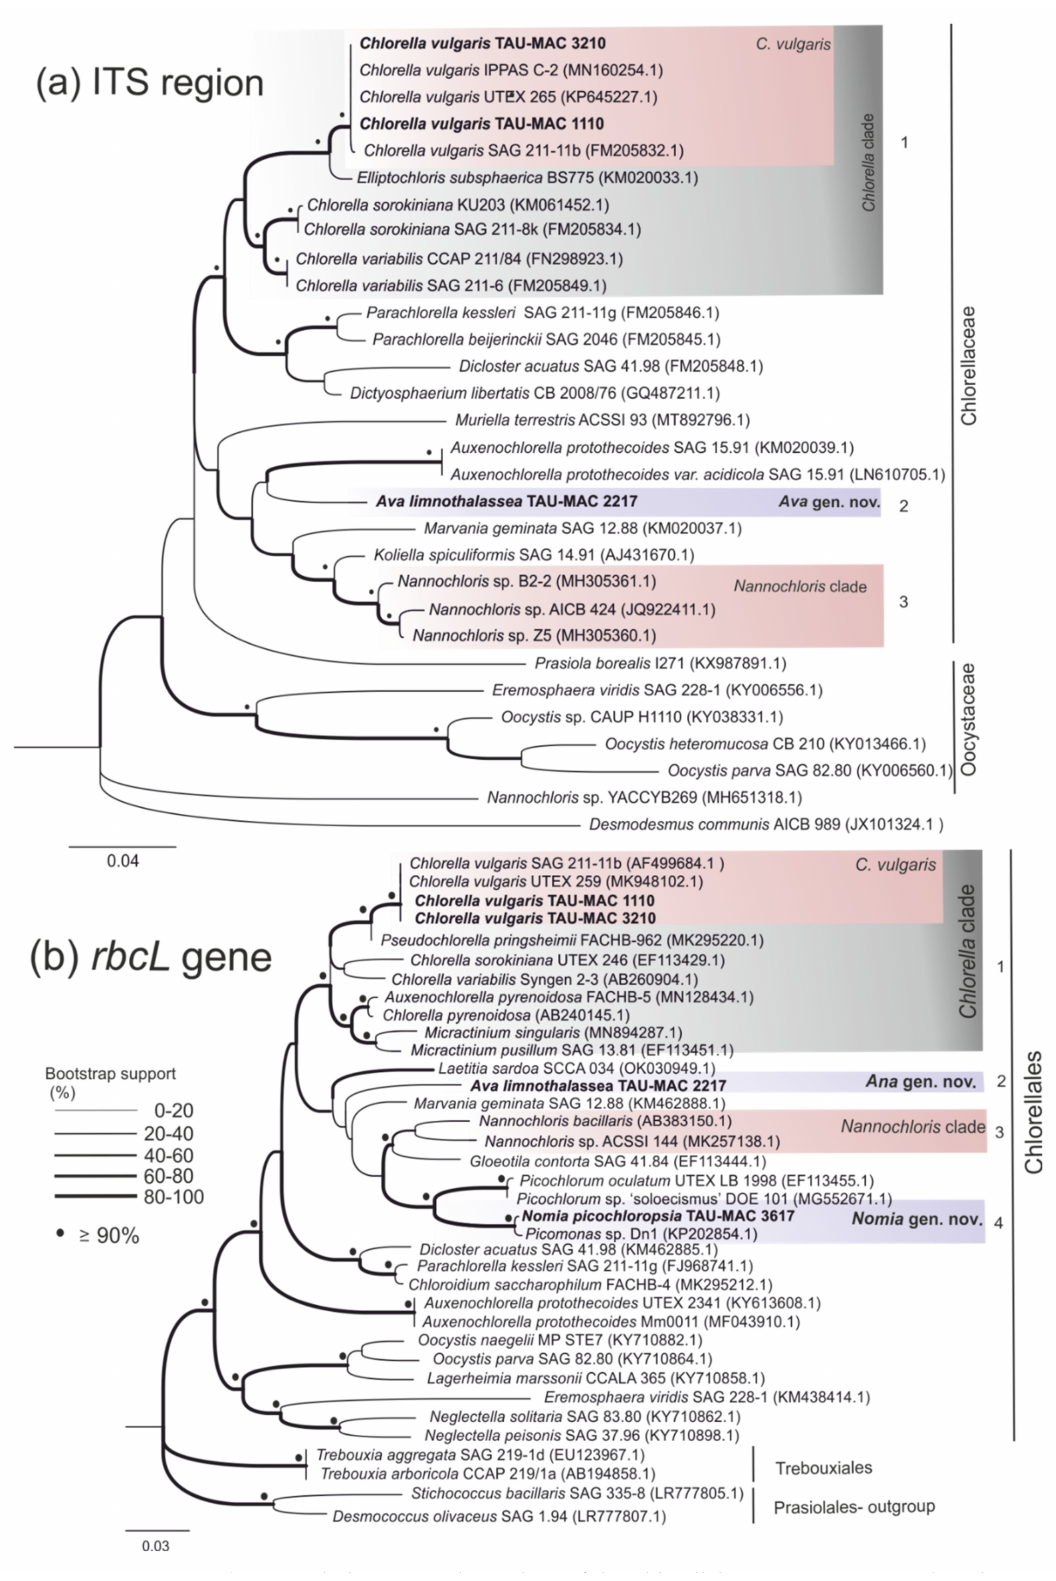
Figure 3. Phylogenetic relationships of the Chlorellales TAU-MAC strains based on ITS region (c. 500bp) and rbcL gene (c. 1050bp) genes. Line thickness at branches (see explanation in figure) represents bootstrap support values (bootstrap support for ML and MP analysis). The numbers in parentheses are GenBank accession